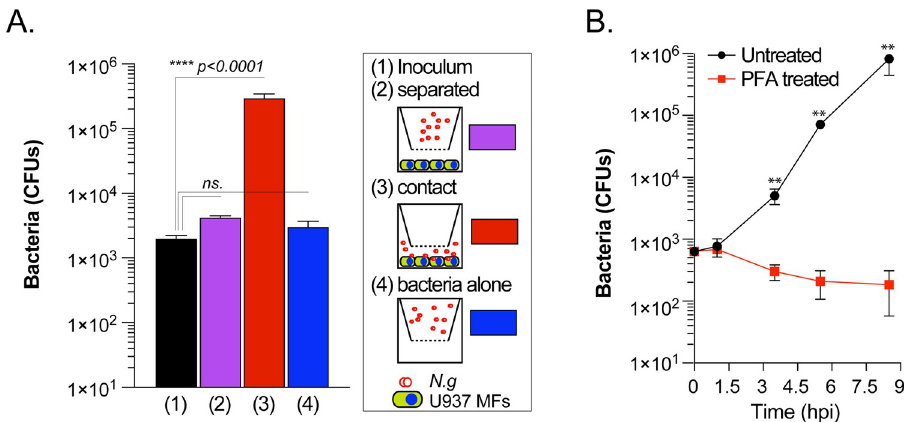
Fig 2. Direct contact with live macrophages is required for gonococcal replication. (A) N . g FA1090 growth under conditions that permit or restrict direct contact with U937 MFs in PBSG media. Contact separation between bacteria and the macrophages is facilitated by a 0.4 μ m filter barrier. Total CFUs recovered at 8hpi are shown. (B) N . g FA1090 growth in association with PFA-fixed U937 MFs in PBSG media. Macrophages were fixed for 45min with PFA (4% vol./vol. in PBS) and extensively washed with warm PBS prior to infection. Total CFUs recovered at the indicated time- points are shown. (A-B) Representative experiments from two (B) or three (A) biological replicates are included. (A-B) For each condition means of technical triplicates ± SD are shown, (A) one-way ANOVA analysis, not significant (ns.); (B) two-way ANOVA, �� p = 0.0016.